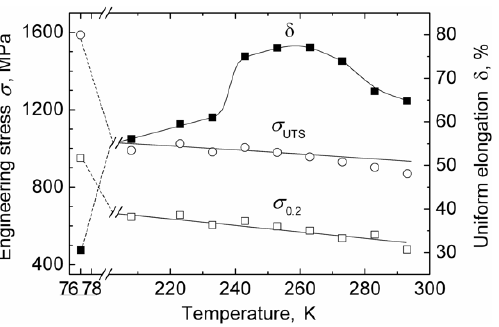
Figure 3. The mechanical properties of Cr-Mn-N steel at low temperatures.